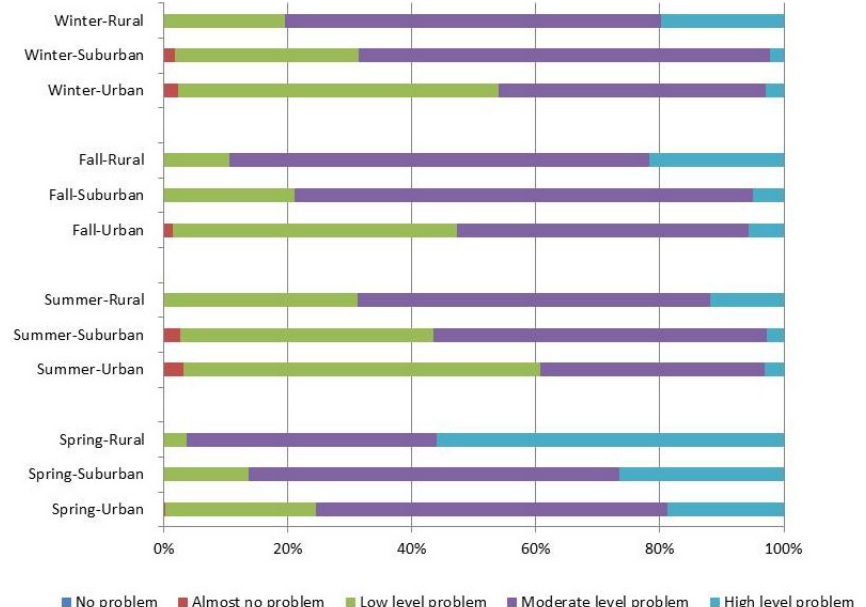
Figure 6. Distribution of the DQD stratified by residency regions.